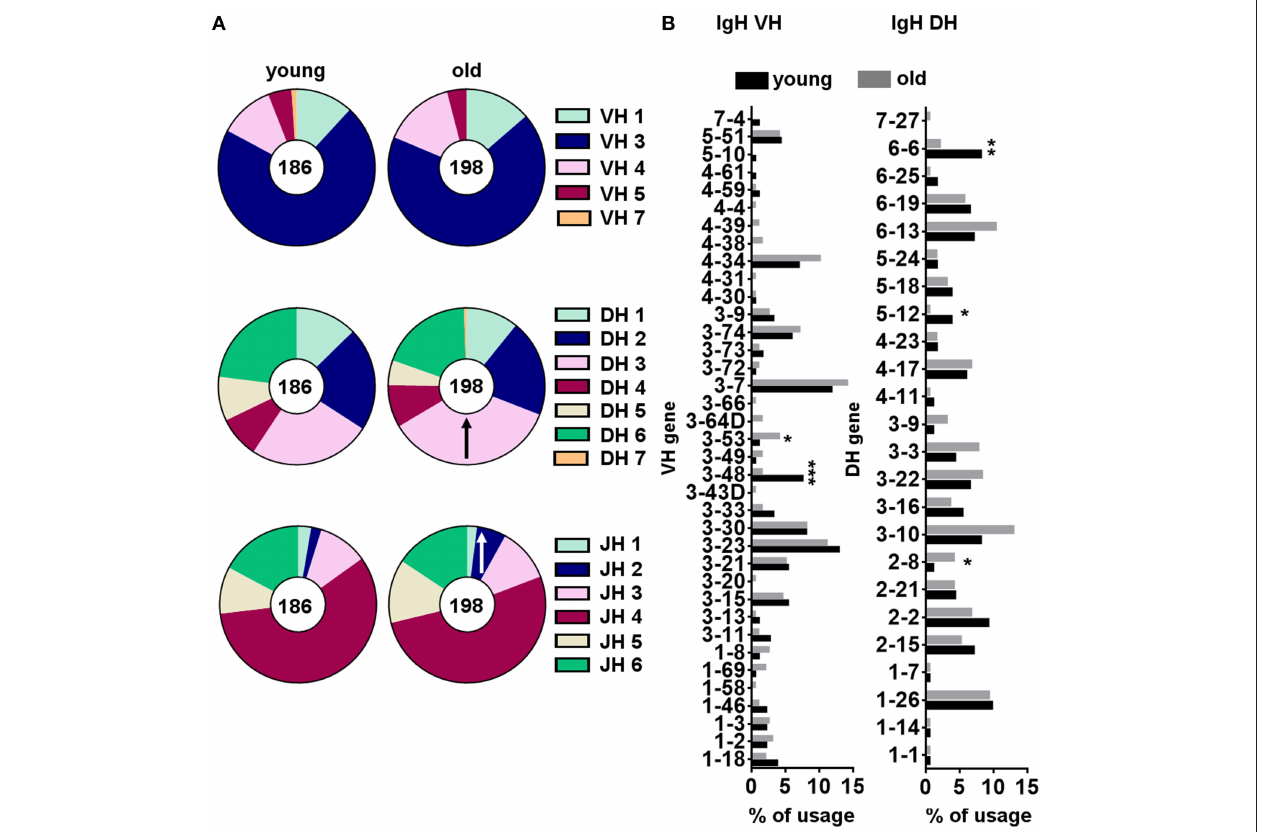
FIGURE 6 | VH, DH and JH gene segment usage frequencies within B-1 cells from young and old donors. Gene usage was calculated as the percentage of the total unique sequences for all the clones from young ( n = 10) and old ( n = 10) donors. From each clonotype only one representative sequence was considered for analysis. Relative frequencies of IGHV, IHGD, and IGHJ gene family (A) , and individual IGHV and IGHD gene segment (B) usage are represented. ↑ indicates a significant increase in IGHD or IGHJ gene family usage in the old B-1 population compared to the corresponding frequency in young B-1 cells. * p < 0.05, ** p < 0.01, *** p < 0.001 by χ 2 test or exact Fisher’s